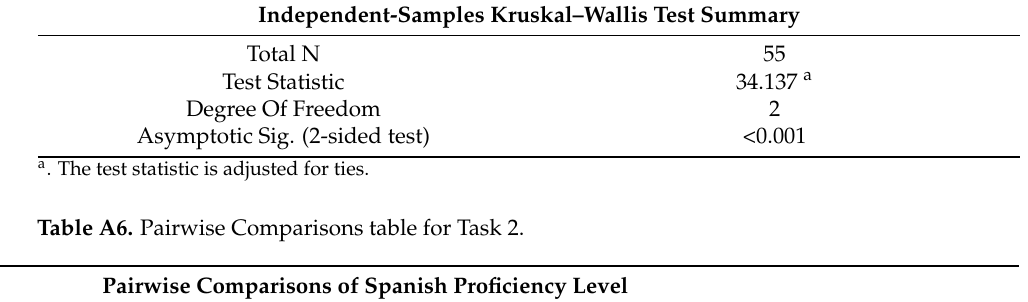
Table A5. Kruskal–Wallis Test result for Task 2.